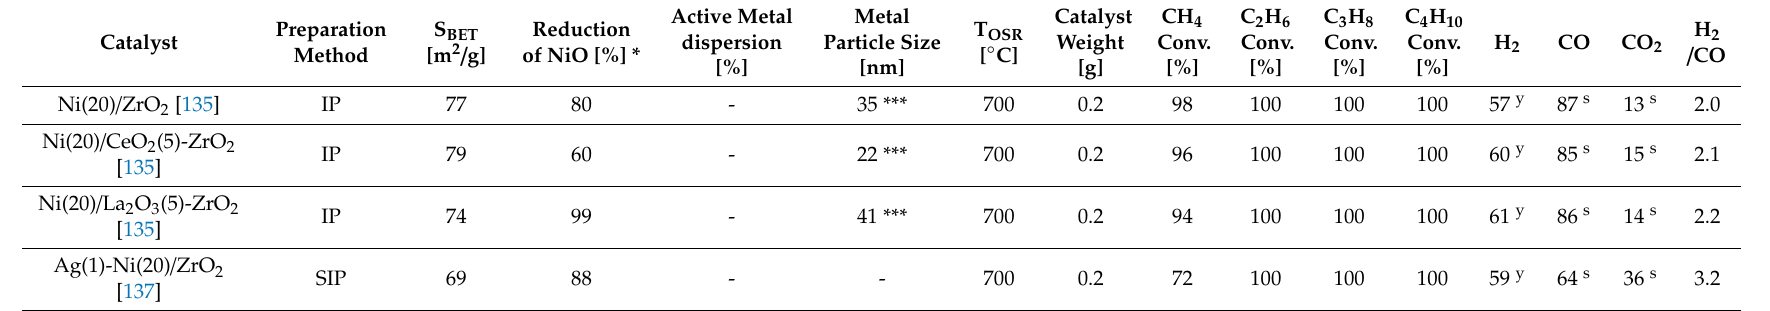
Table 4. The physicochemical and catalytic characterization of the catalytic systems used in the OSR of LNG